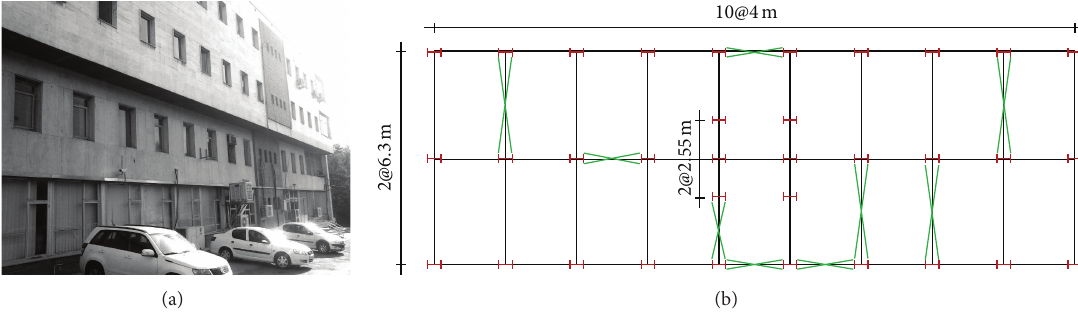
Figure 2: Case study building: (a) general view, (b) typical plan view.